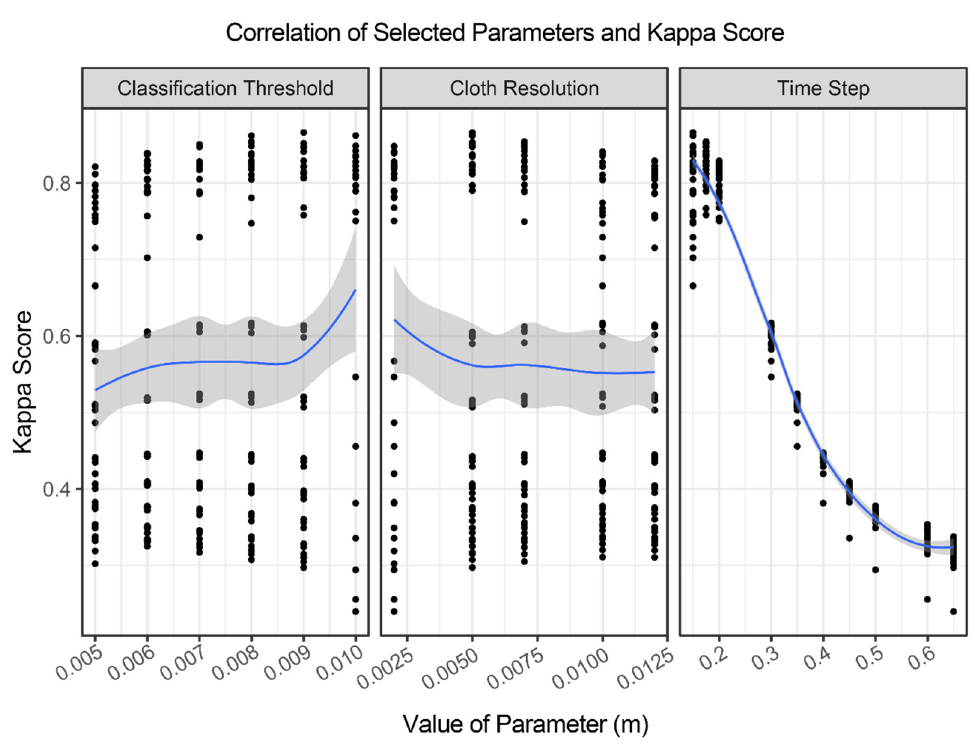
Figure 8. CSF algorithm parameter performance results by Kappa score. The blue line shows the trendline generated through locally estimated scatterplot smoothing, and the grey areas represent the corresponding confidence interval of 95%. Table 1. Input parameters of the highest performance by Kappa scores for CSF and MSBF based on the subset of the testing